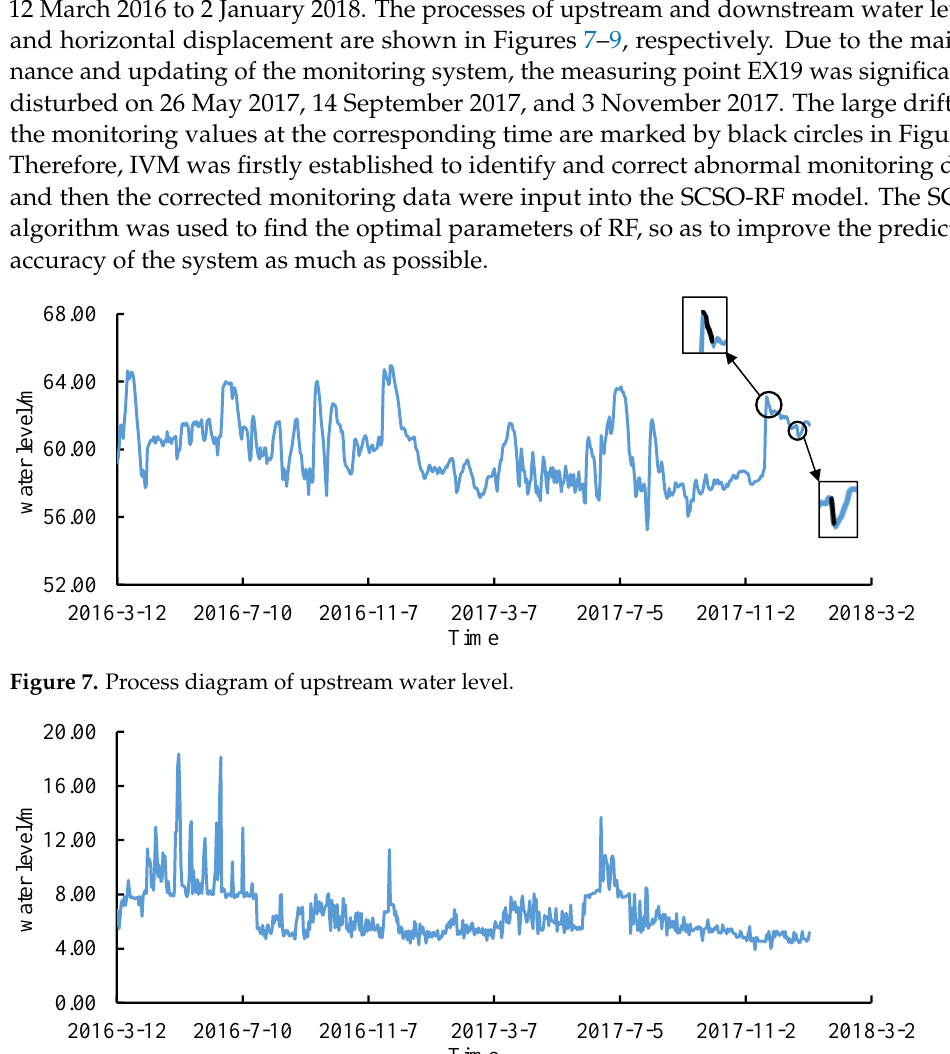
Figure 8. Process diagram of downstream water level.